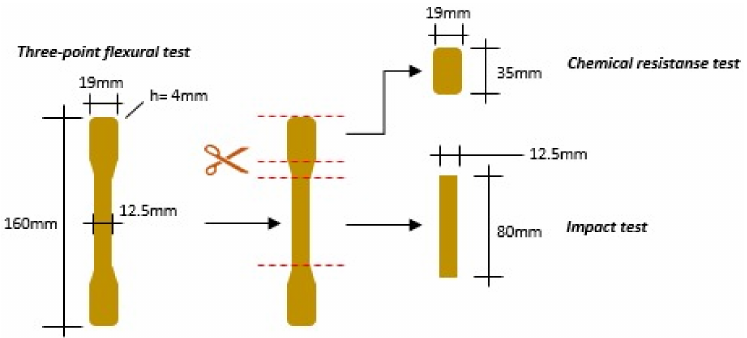
Figure 2. Process for obtaining the